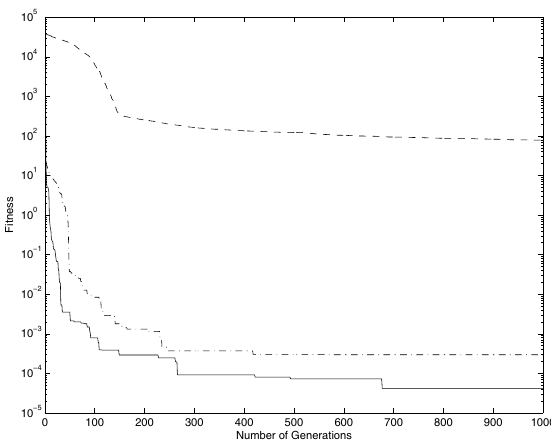
Fig. 4. Convergence procedures of CSA, SA, and hybrid algo- rithm in 50-dimension Zakharov function optimization. Dash- dotted line: CSA, dash line: SA method, solid line: hybrid